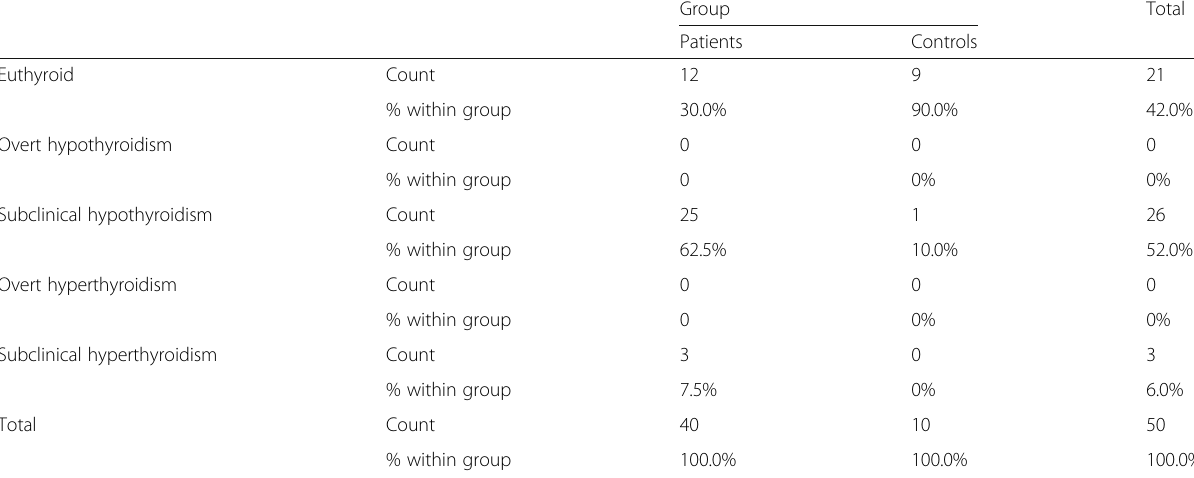
Table 5 Comparison of the studied groups regarding thyroid dysfunction